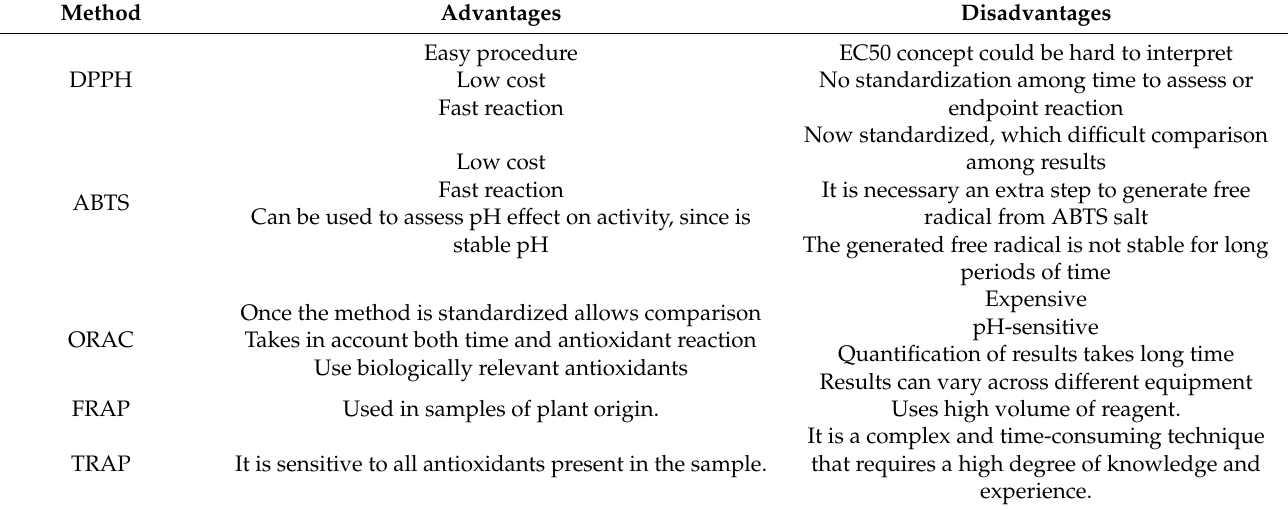
Table 1. Advantages and disadvantages of DPPH, ABTS, ORAC and FRAP, TRAP